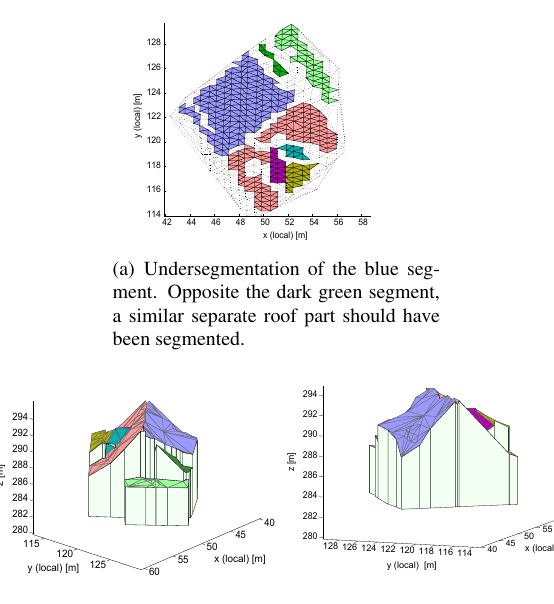
(b) Reconstruction of a step edge (c) Reconstruction, where no step between the blue and the dark green edge can be modelled, because no segment. different segments are identified. Figure 9. Smoothed roof effect due to undersegmentation. If the roof height layer is undersegmented no step edges can be created, because only one local height layers is identified. However, the roof is approximated to fit the input point cloud in detail.